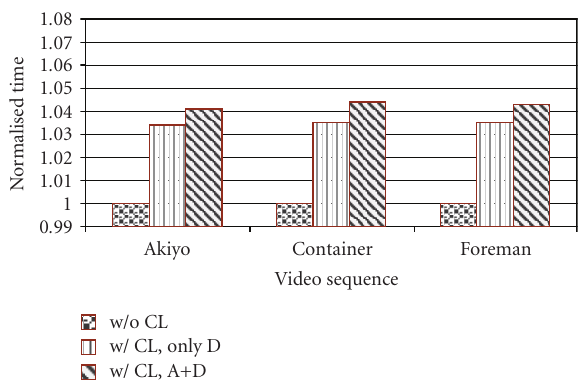
Figure 4: Video packet processing time at the AP bu ff er.